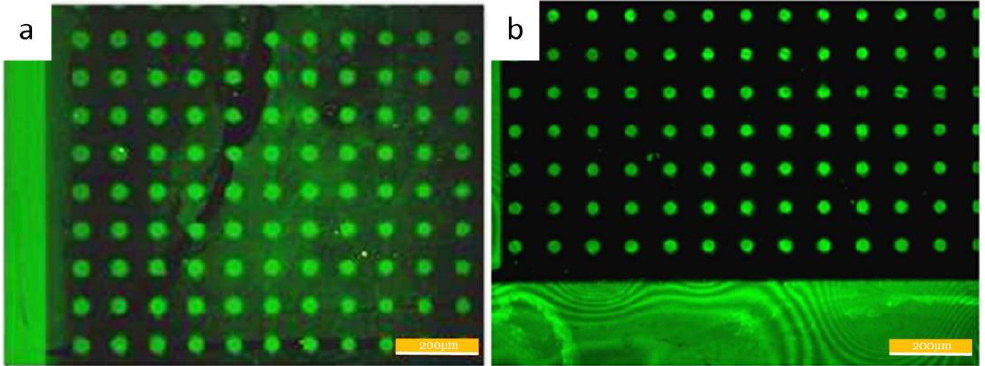
Figure 5. ( a ) The pattern after the passivation with the PEG–silane concentration of 1 mM. ( b ) The pattern after the passivation with the PEG–silane concentration of 10mM.